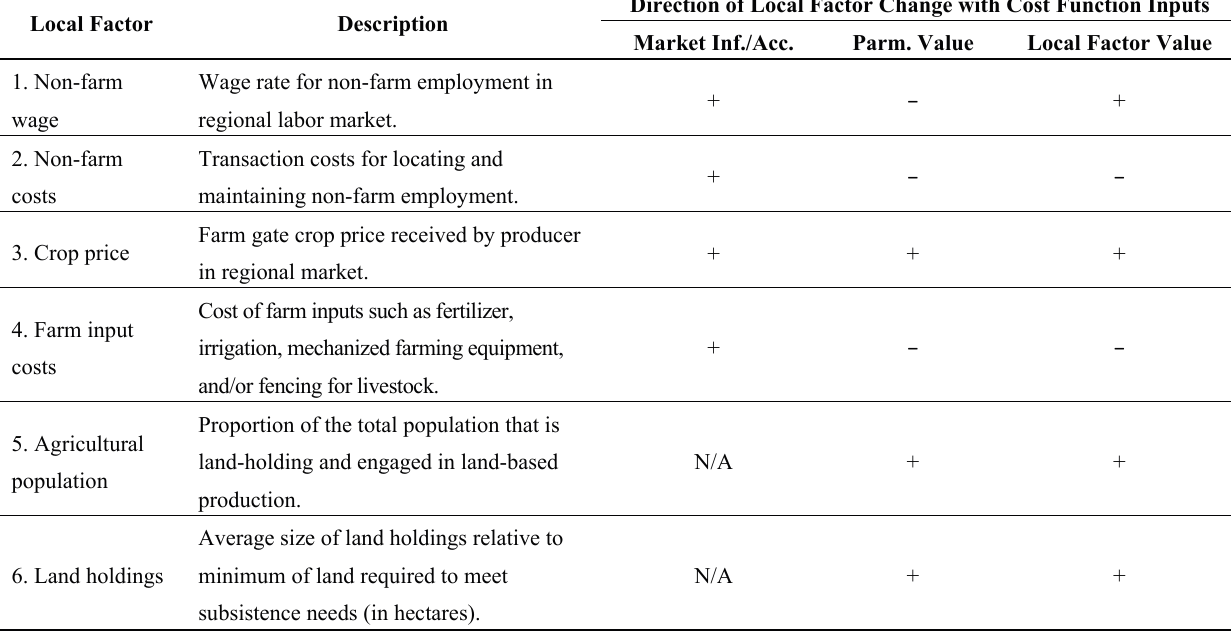
Table 3. Set of parameters used with a genetic algorithm to link global data values to local economic and environmental factors through a set of cost and price functions (1–4) described in SI-1.2.4, or specify land allocation and the number of producers (5–6) for each case. The relationships ( i.e. , direct (+) or inverse ( − )) between each local factor and global market settings and/or parameter values are also